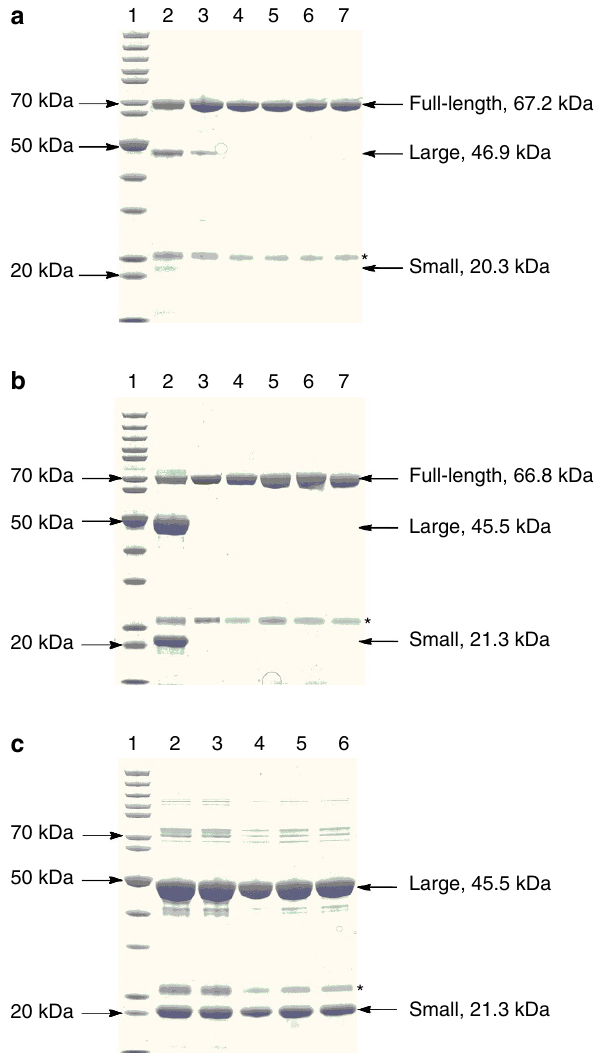
Figure 4 | Analysis of autoproteolytic activity on SDS–PAGE gels. The asterisk indicates an unknown impure protein associated with the purification of g -GT homologues/variants. ( a ) Ant6. Lane 1, protein standard; Lane 2, Ant6 wild-type; Lane 3, Ant6-T430S; Lane 4, Ant6-T430C; Lane